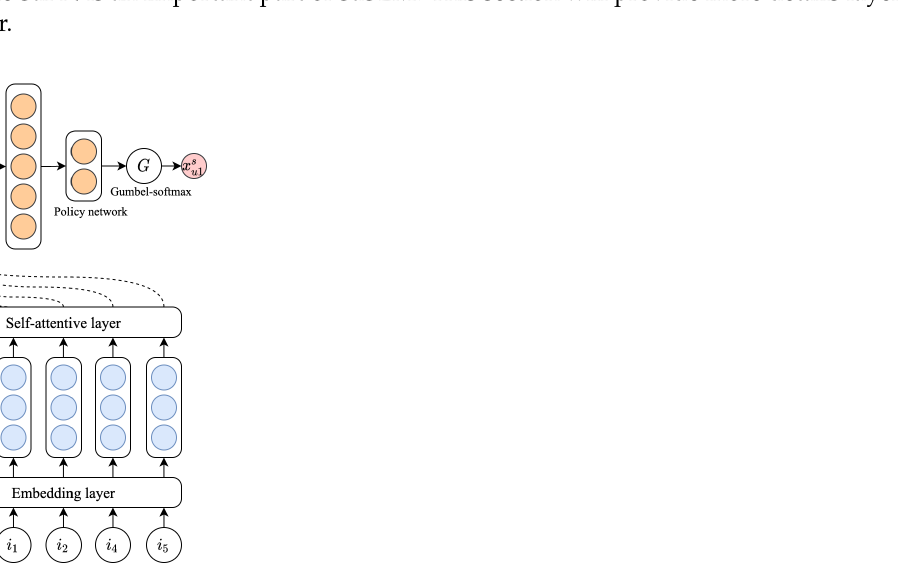
Figure 3. An illustrative example of the self-attentive policy network. It takes as input the user u and items in the set S = { i 1 , i 2 , i 3 , i 4 , i 5 } . It shows how the indicator variable x s